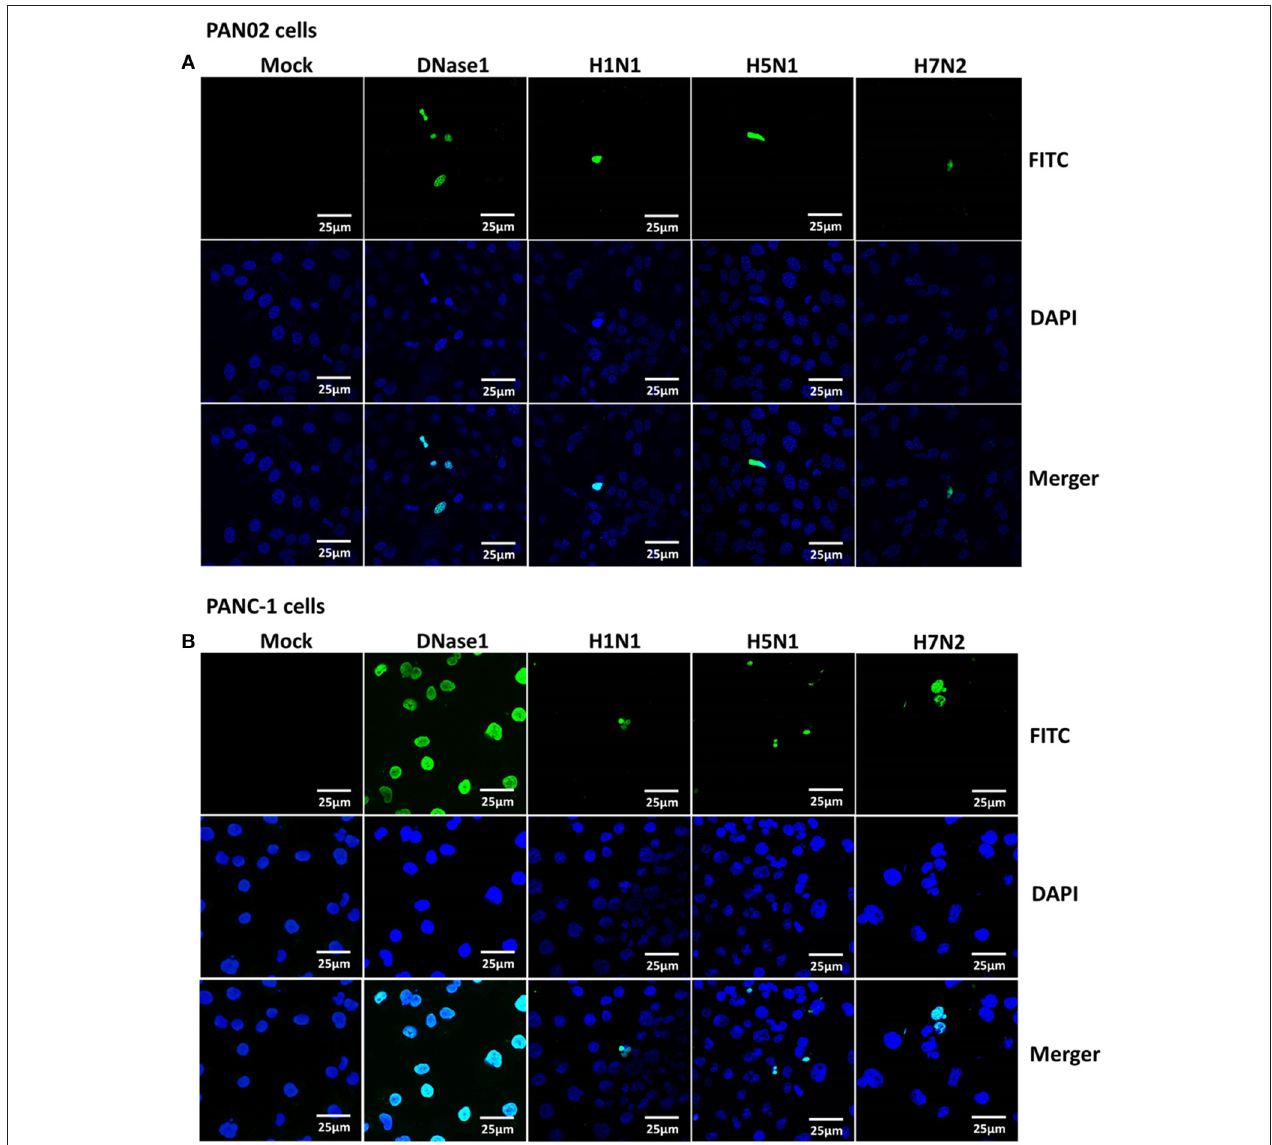
FIGURE 6 | Apoptosis was induced in H5N1 IAV-infected pancreatic cells. (A) PAN02 and (B) PANC-1 cells were mock-treated or infected with H1N1, H5N1, or H7N2 at an MOI of 1 for 12h. A terminal deoxynucleotidyl transferase-mediated dUTP-biotin nick end-labeling (TUNEL) assay was used to measure apoptosis in PAN02 and PANC-1 cells with DNase I as a positive control. Blue showed nucleus and green showed positive TUNEL